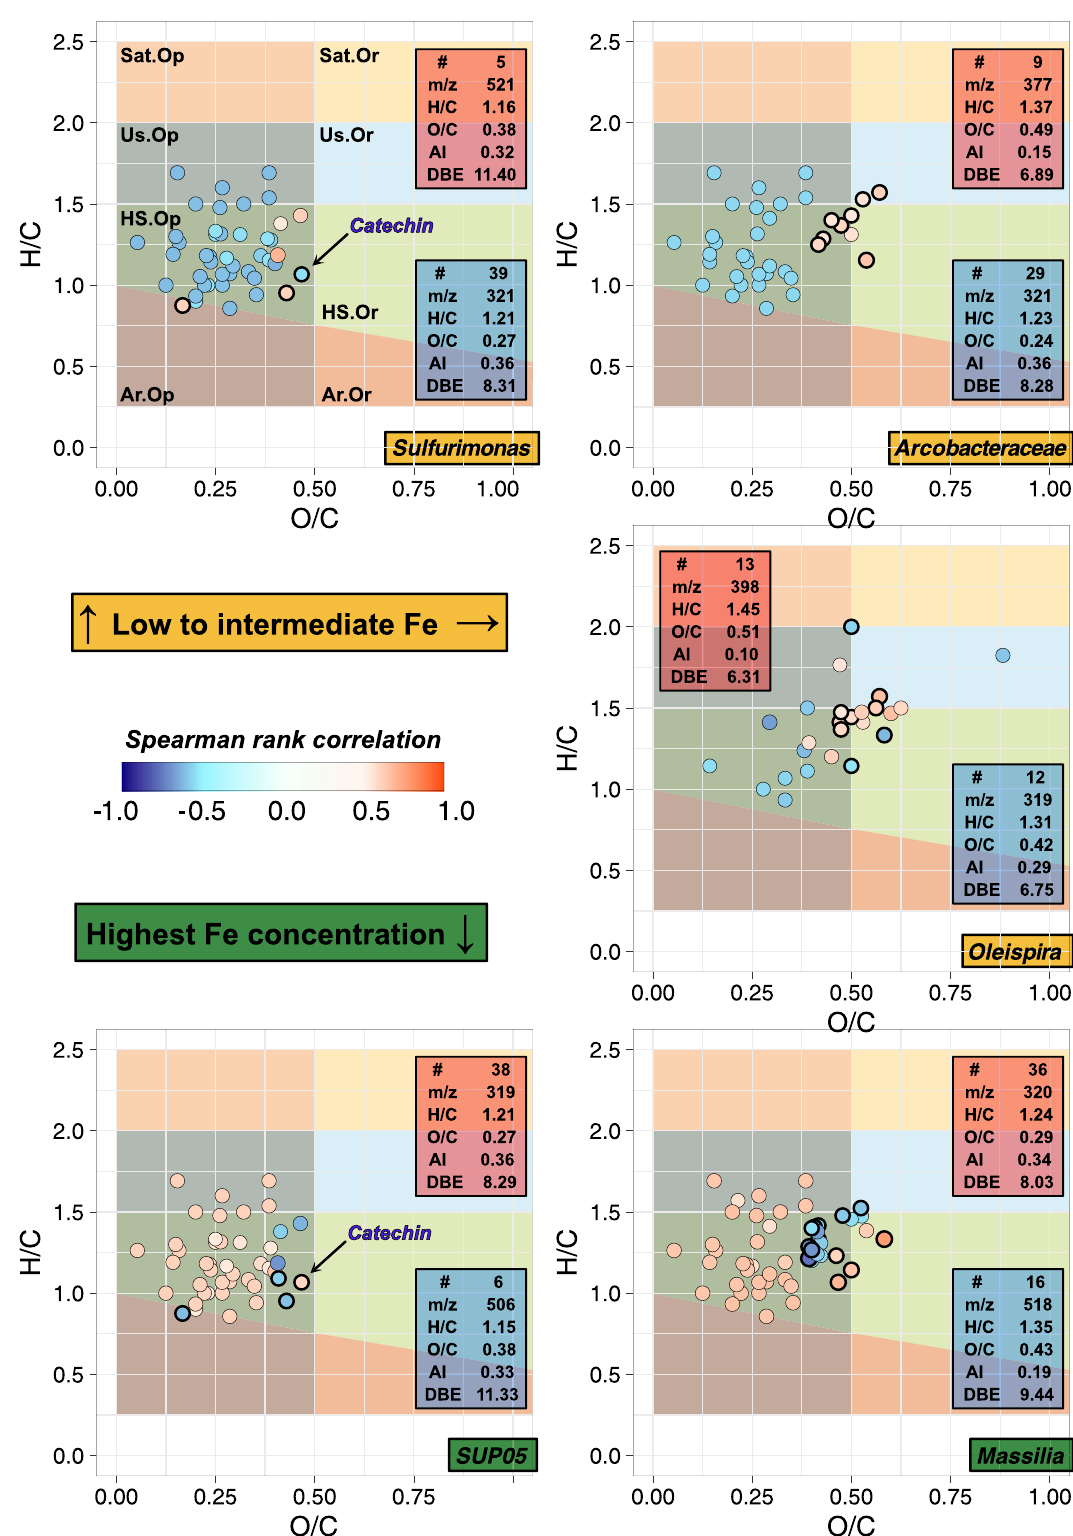
Figure 5. Van Krevelen plots depicting formulae that show a significant positive/negative correlation ( p < 0.05) with the relative abundance of specific microorganisms, i.e., Sulfurimonas , Arcobacteraceae , Oleispira , SUP05 and Massilia . Strength of the Spearman rank correlation indicated by color bar (only r > 0.5 | r < − 0.5). Only the highlighted formulae (open black circles) are not also corelated with Fe. Colored areas indicate organic compound groups as defined in 53,73 . To maximize comparability, all sample sets were limited to the 1000 most abundant formulae and total intensity normalized to 1. Average characteristics of formulae for which relative intensity correlates positively (red) and negatively (blue) with relative abundance of different microbial groups provided in insets. Abbreviations refer to number of formulae (#), average mass of the respective formulae (m/z), elemental ratios (H/C and O/C), aromaticity (AI) and double bond equivalent (DBE). Definitions of the latter are given in